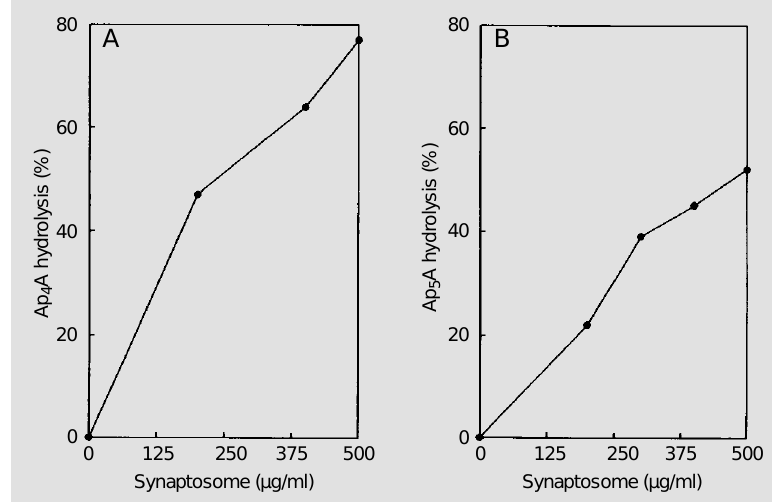
Figure 1 - Ap 4 A (A) and Ap 5 A (B) hydrolysis as a function of synaptosome protein concentra- tion. The assay mixture contained 20 mM Tris/HCl, pH 7.5, 2.0 mM MgCl 2 , 10 mM glucose and 225 mM sucrose in a final volume of 200 µl. The samples were incubated for 60 min at 37 o C. The data are representative of three independent experiments with different synapto-